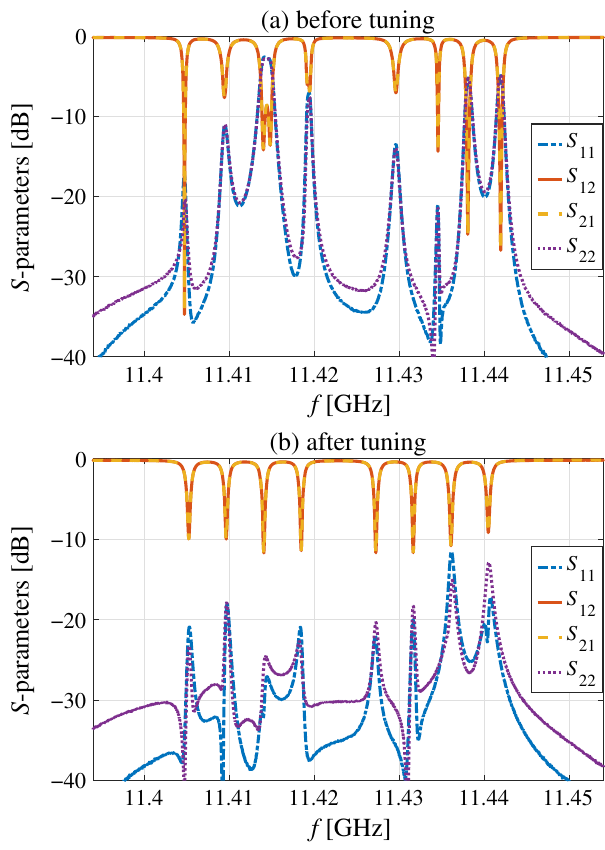
FIG. 9. S -parameters of the correction cavity chain (a) before and (b) after tuning. The transmission loss after tuning is − 0 . 24 dB.